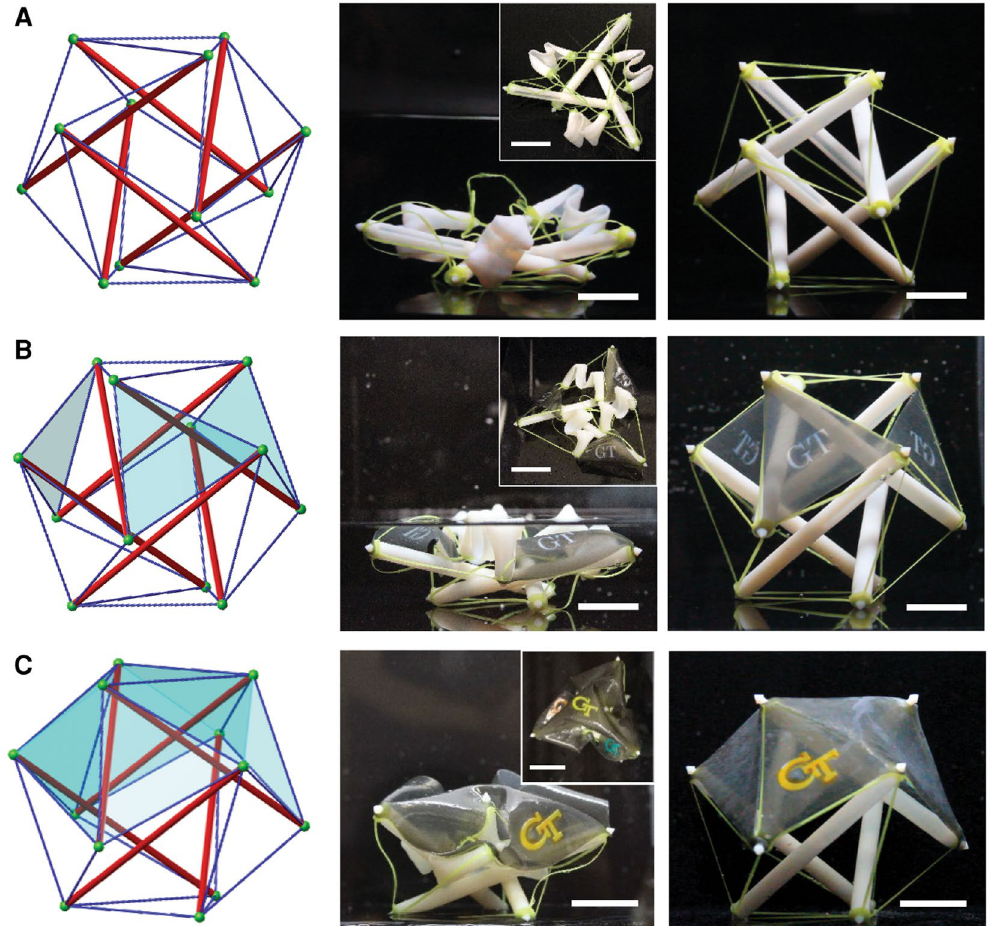
Figure 3. Deployment of 6-strut spherical tensegrity. ( A ) Deployment of a spherical tensegrity using the partial folding strategy to improve reliability of deployment. ( B ) Positioning of three discrete pieces of surfaces into space. ( C ) Deployment of a continuous surface supported by the active tensegrity to form a tent. The resultant structural system mimics the fundamental structure of vertebrates, with the membrane as skin, elastic cables as muscles, and relatively rigid struts as the skeleton (biomimetics). The scale bars represent 15